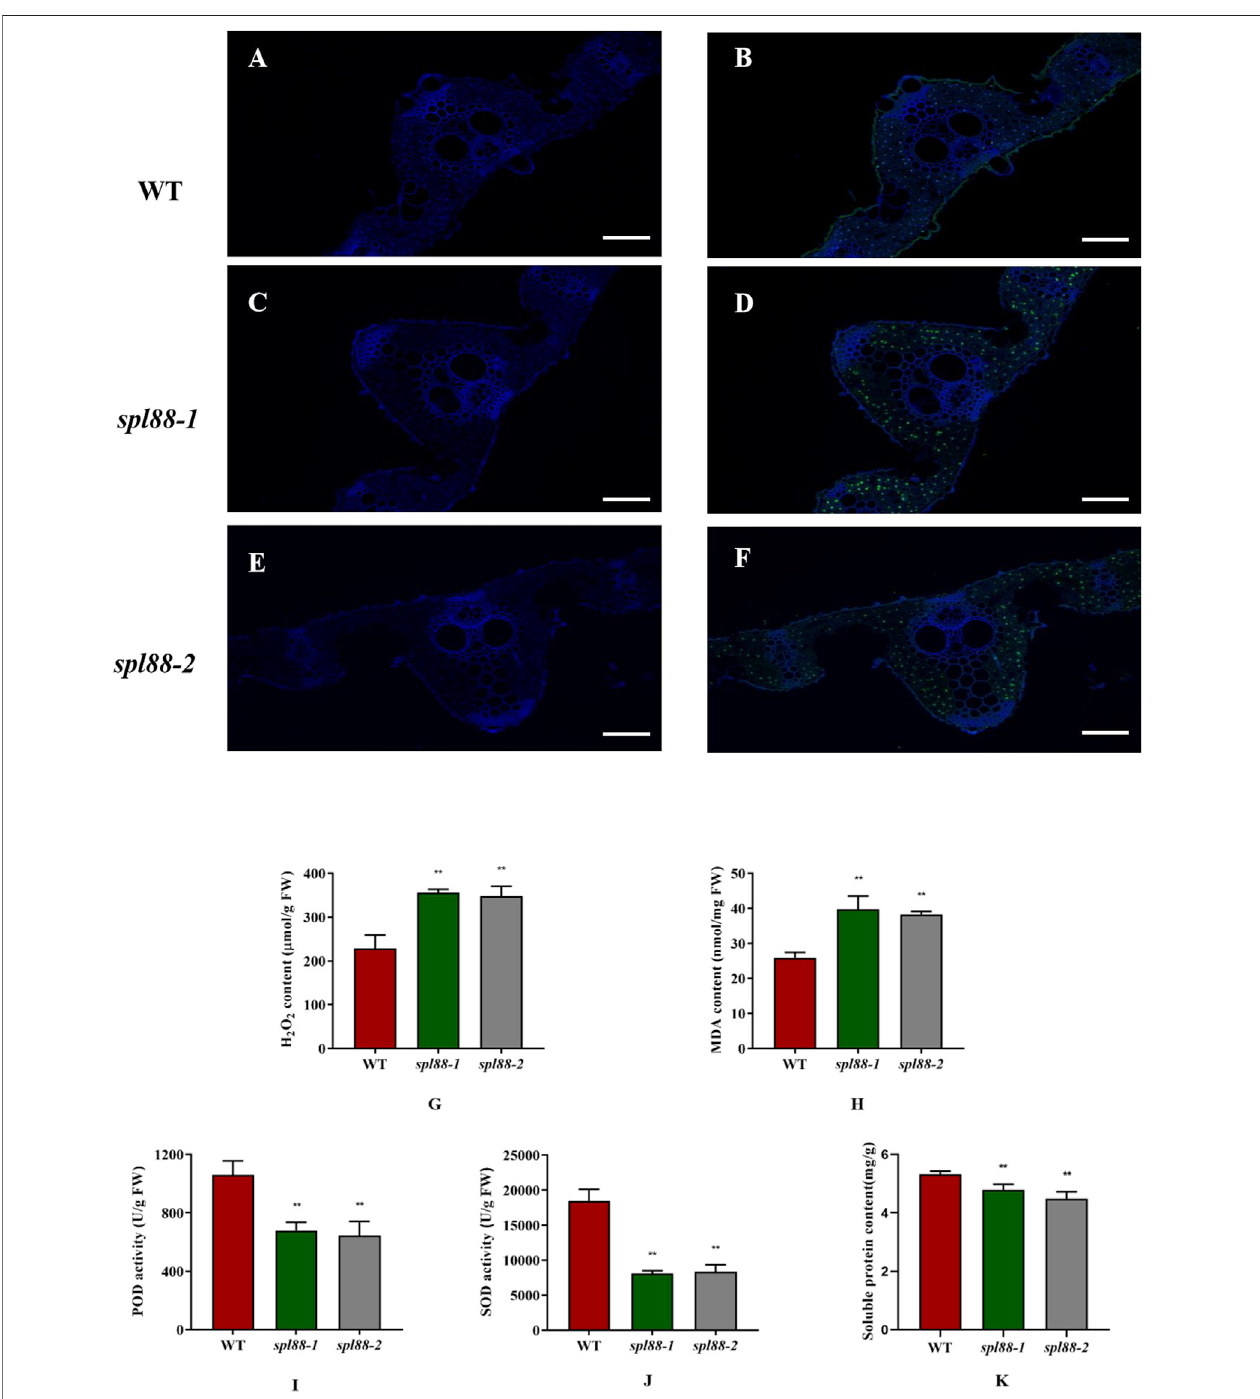
FIGURE 4 | Physiological and biochemical analysis of wild-type and mutant plants at the tillering stage. (A – F) : TUNEL assay of DNA fragmentation in mesophyll cells; Bar: 200 μ m. (G – K) : H 2 O 2 , MDA, and soluble protein contents of leaves, POD, and SOD activities in the leaves. *indicates signi fi cance at p ≤ 0.05 by Student ’ s t -test, ** indicates signi fi cance at p ≤ 0.01 by Student ’ s t -test.